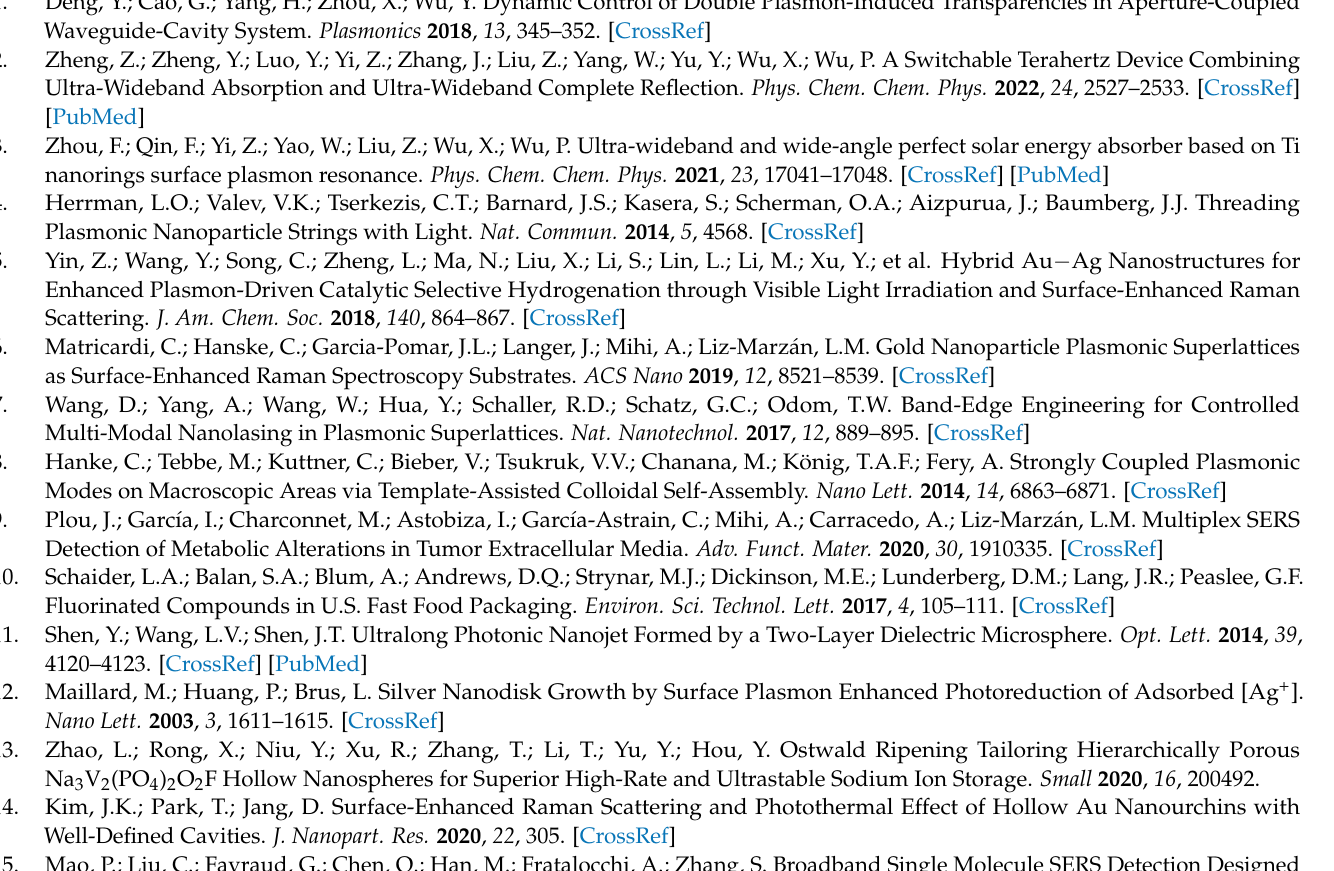
2000 nm; Figure S7: Absorption spectrum of silver precursor solution; Figure S8: Large area image of gold plasmonic superstructure array and single gold nanocluster; Figure S9: SERS intensities of R6G molecules using the plasmonic superstructure arrays fabricated by singe- and two-photon absorption; Figure S10: Raman spectrum of 4 ppm PFOA in pure water on superstructure array; Figure S11: The absorbance of crystal violet solution mixed with PFOA; Figure S12: SERS spectra of the crystal violet mixed with PFOA using 1000 nm the plasmonic superstructure arrays; Figure S13: A comparison of CV solution mixed with polyvinylpyrrolidone and perfluorooctanoic acid. Reference [47] is cited in the Supplementary